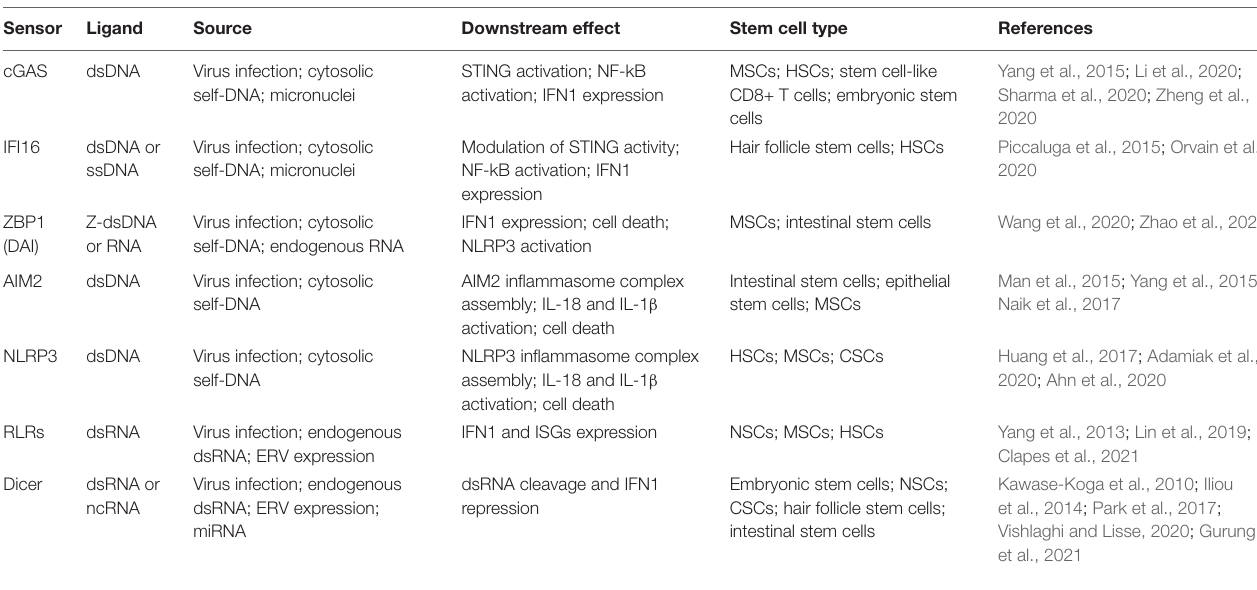
TABLE 1 | List of DNA and RNA sensors mentioned in this review, the relative downstream effect and examples of stem cell types shown to express these sensors. Sensor